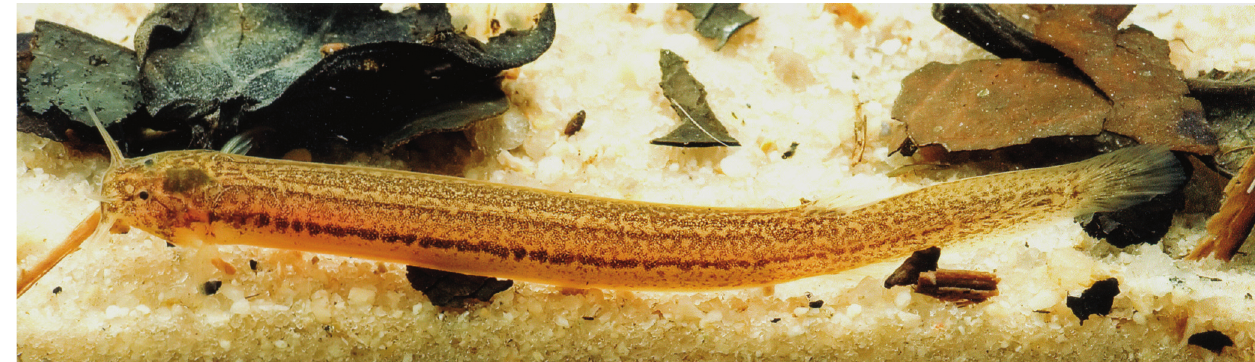
Fig. 1. Listrura camposi , MZUSP 95189, 46.4 mm SL, live specimen; Brazil, São Paulo State, município de Pedro de Toledo. Photo by Cristiano Moreira.